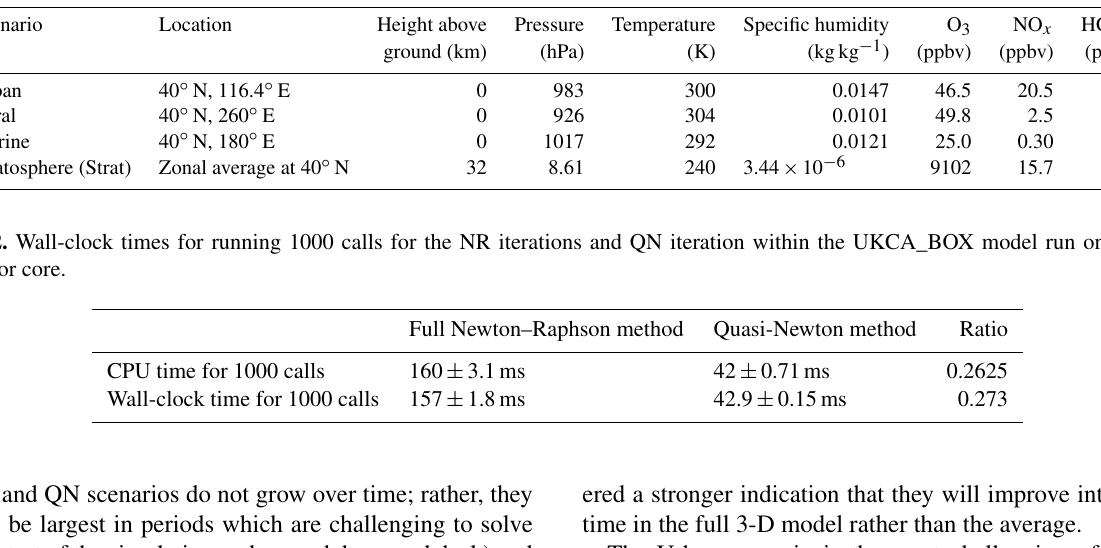
Table 1. Summary of data points from UM model runs used to initialise UKCA_BOX scenarios, parameters describing atmospheric condi- tions of each scenario and initial concentrations of select chemical species. In each case, data are extracted from a 10-year July average run of the UM-UKCA model for the year 2000.